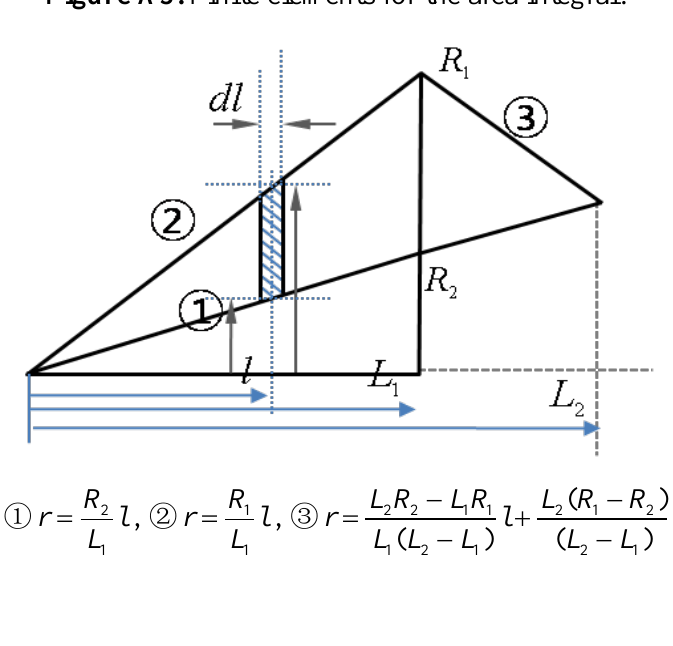
Figure A3. Finite elements for the area